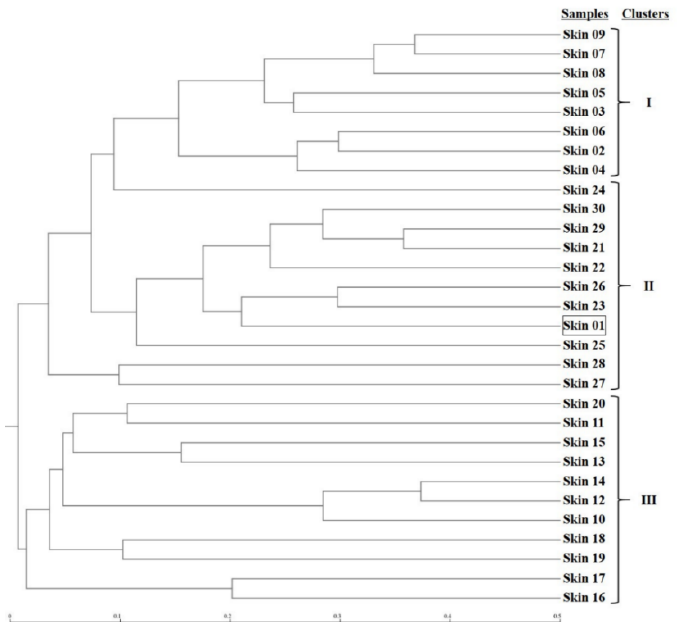
Figure 4. Dendrogram for phylogenetic distance of forearm skin microbiome. Clusters I, II, and III were predicted and classified among forearm skin microflora from various sample sources based on Newick Standard. The square represents skin sample #1 as an outlier. The scale bar unit represents 0.1 Phylip distance index value between the two samples.